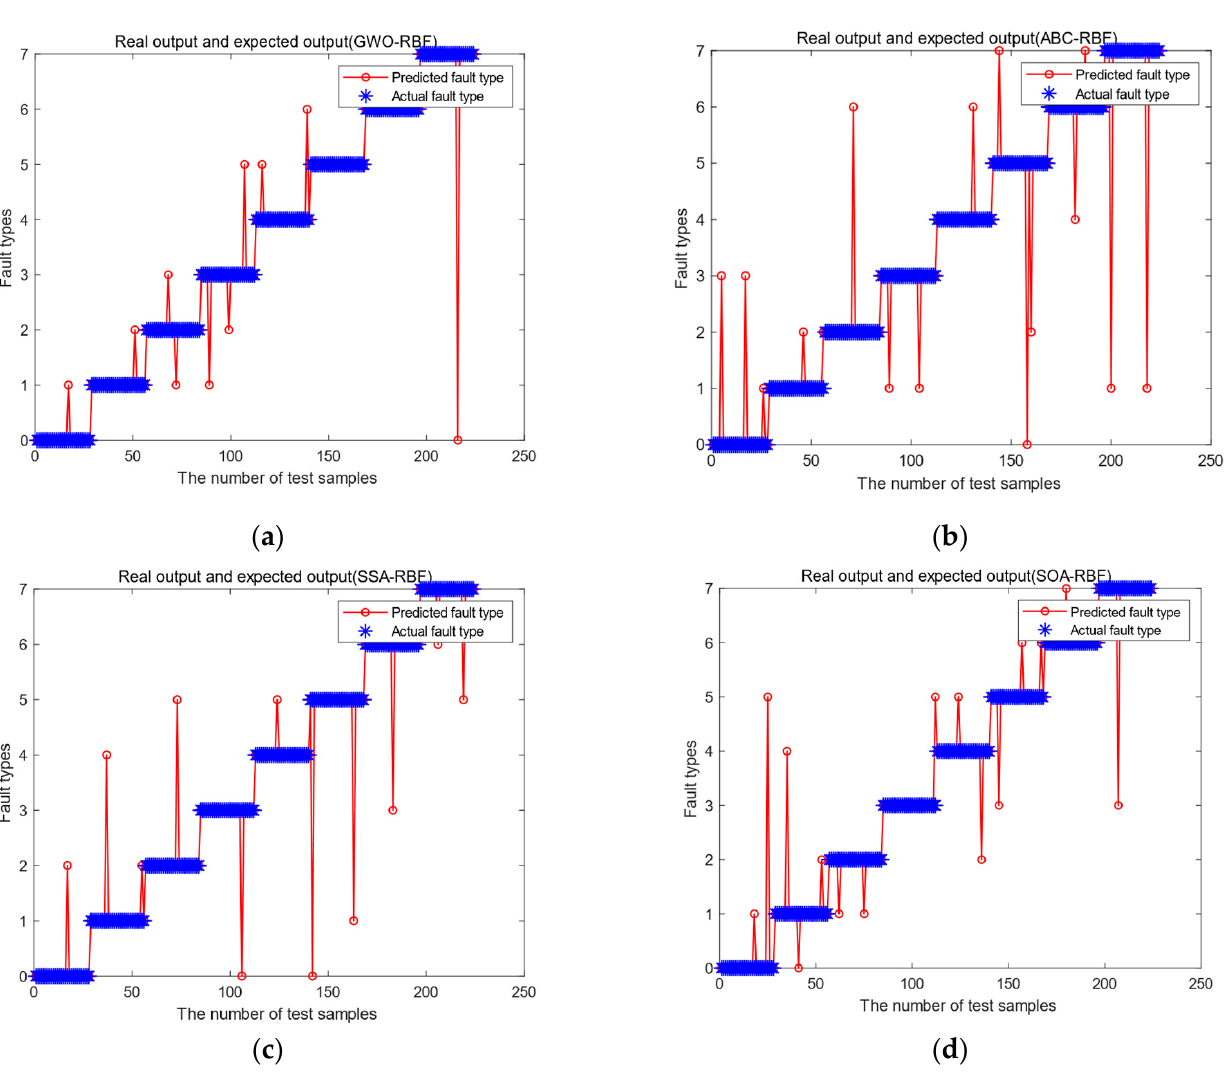
Figure 7. The results of fault diagnosis of the three WOA based RBF networks: ( a ) GWO-RBF;